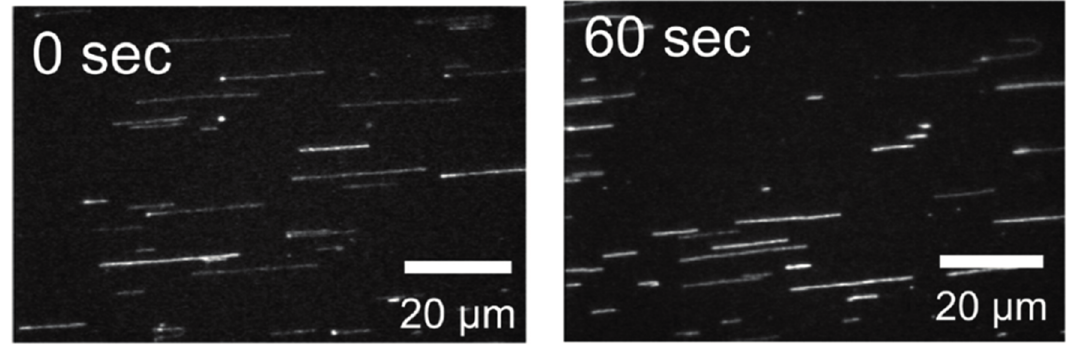
Figure 8. Typical photographs of DNA molecules after combing: before (0 s) and after APP treatment of 1 min. Adapted from [60] with the permission of AIP Publishing LLC,